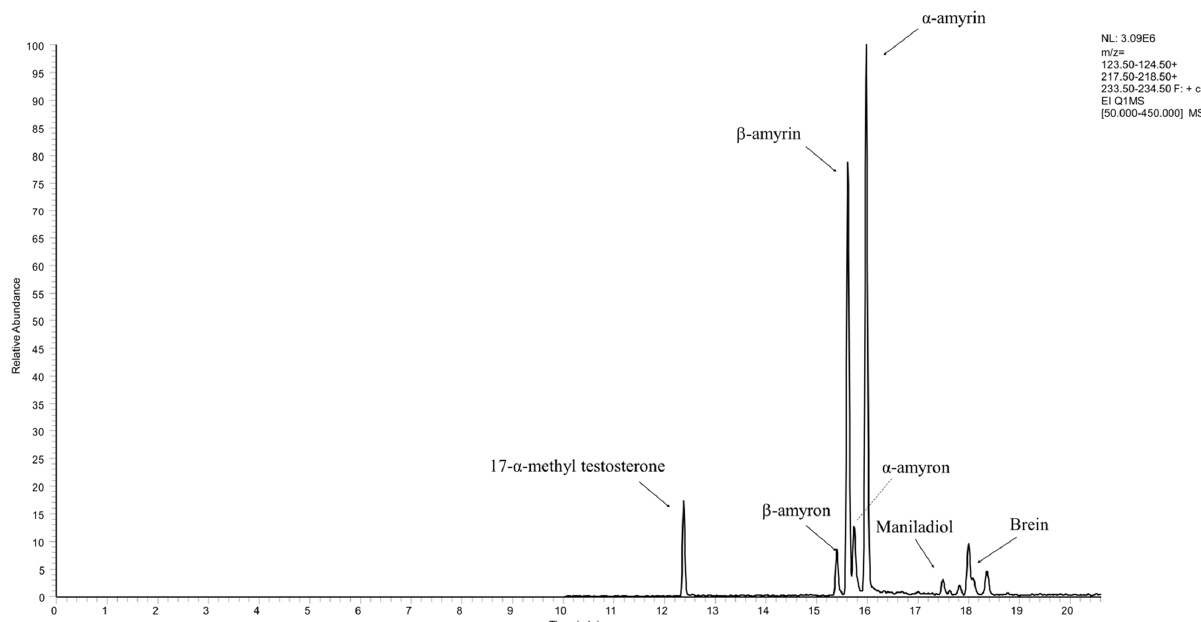
Figure 1. The figure shows the separation in PHR of 17- α -methyl testosterone (internal standard) (124 m / z ), β -amyron (218 m / z ), β -amyrin (218 m / z ), α -amyron (218 m / z ), α -amyrin (218 m / z ), maniladiol (234 m / z ) and brein (234 m / z ) by their extracted ion chromatogram (EIC), as reported in brackets.